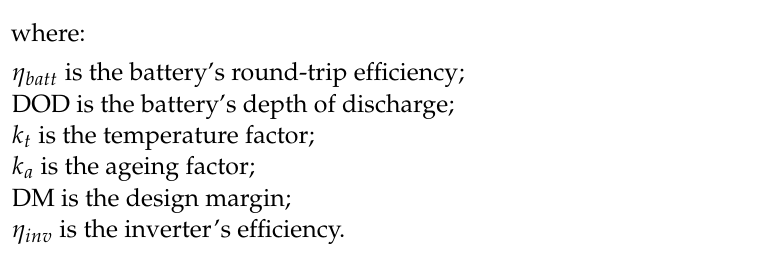
Table 2. Parameters and associated values to calculate the nominal battery capacity (extracted from [35]). Round-Trip eff. η